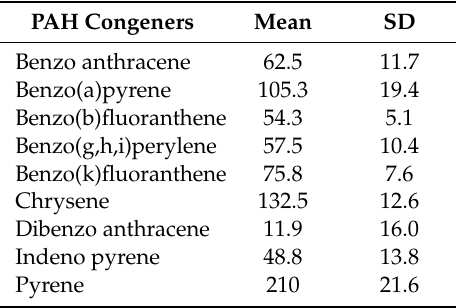
Table 2. Hydrocarbon concentrations (mg kg − 1 ) in the sediment before the experiments. Reported values are mean and standard deviations (SD). PAH = polycyclic aromatic hydrocarbon.